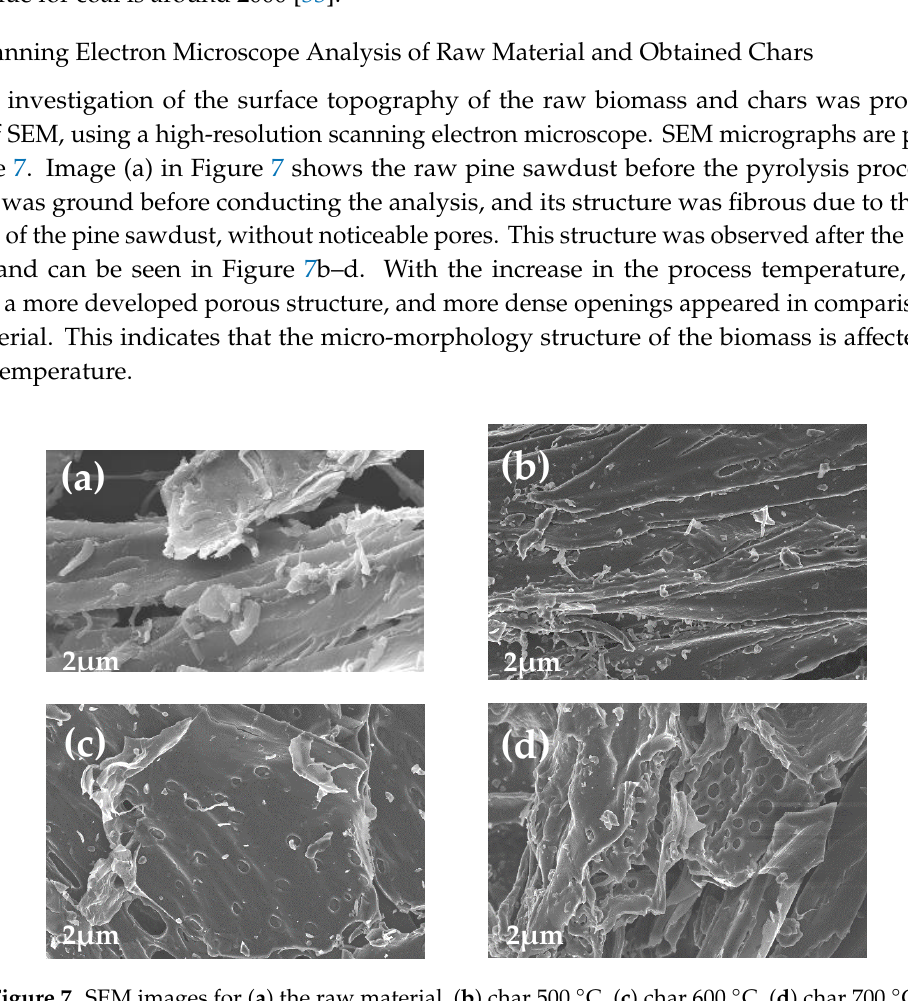
Figure 7. SEM images for ( a ) the raw material, ( b ) char 500 °C, ( c ) char 600 °C, ( d ) char 700 °C.